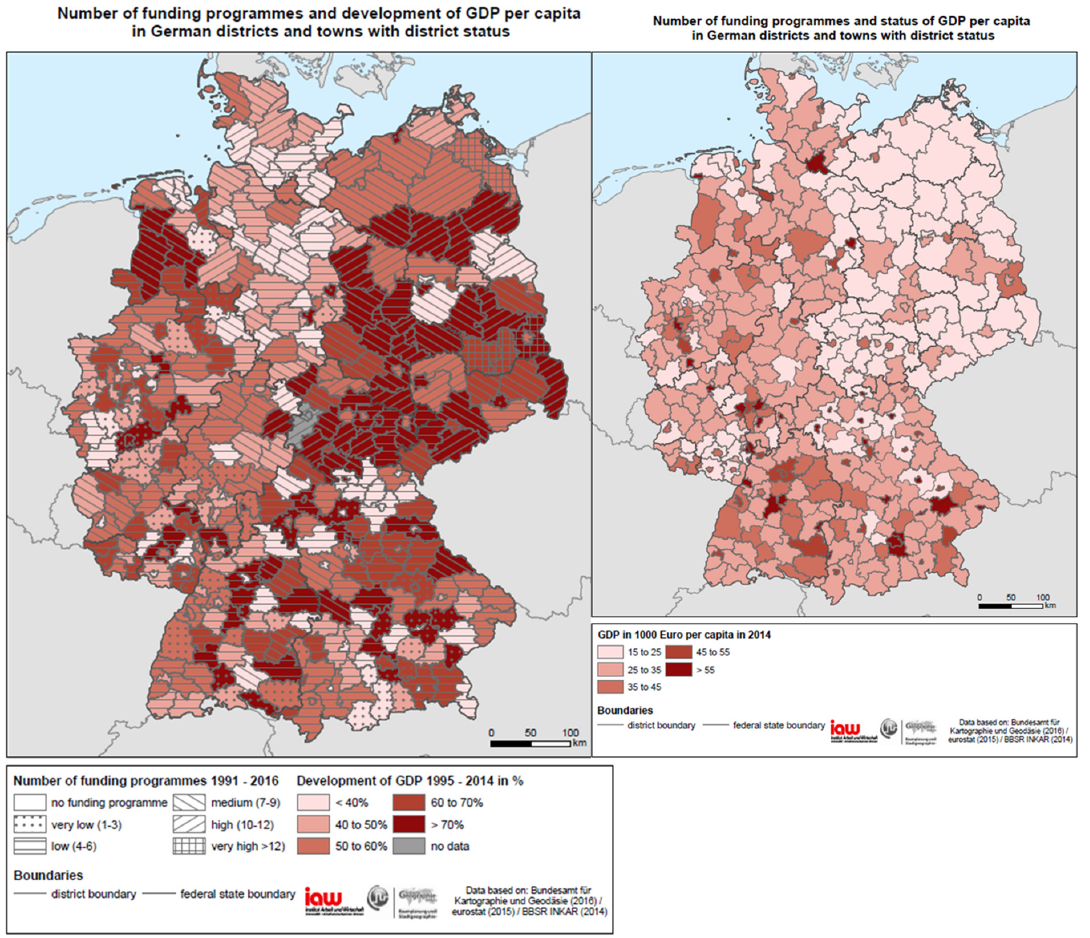
Figure 9. Number of programmes and development of gross domestic product (GDP) per capita in German districts and towns with district status ( left ) and status of GDP per capita in German districts and towns with district status ( right ). Source: authors’ compilation (Department of Geography Giessen, Institute for Labour and the Economy Bremen).